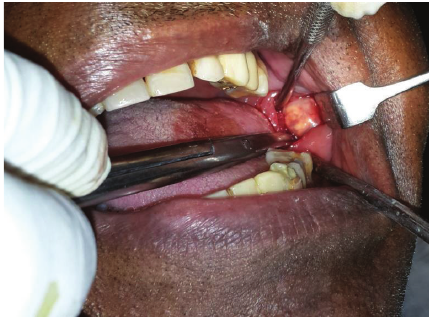
Figure 1: Asymptomatic nodule in left retromolar region.